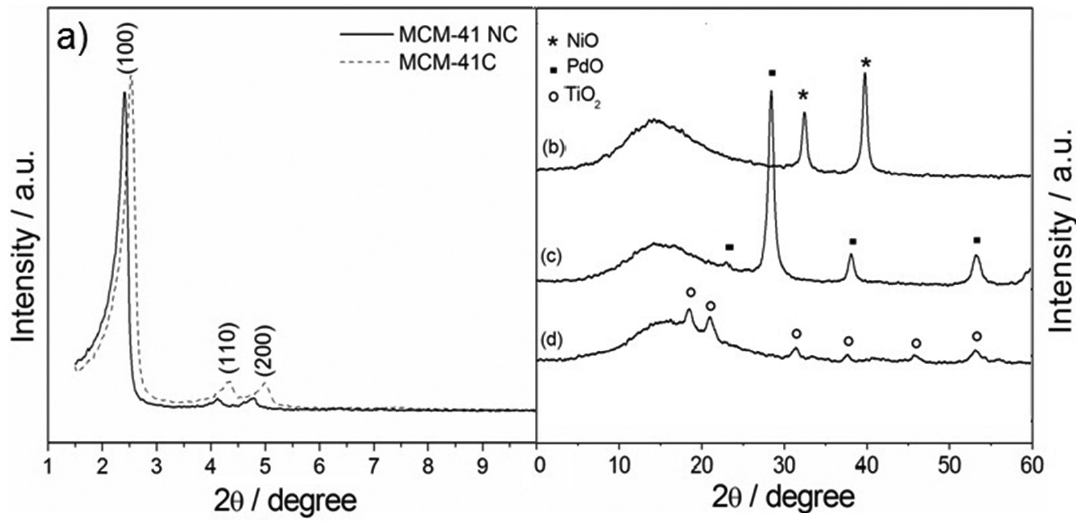
Figure 1. XRD patterns for (a) MCM‑41 calcinated (C) and non‑calcinated (NC); (b) NiO/MCM‑41; (c) PdO/MCM‑41 and (d) TiO MCM‑41.